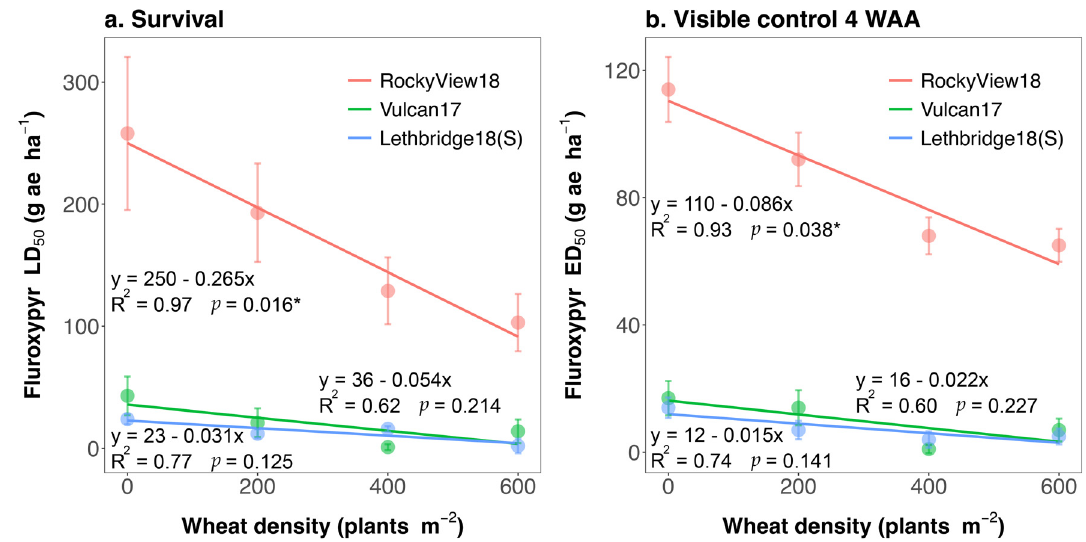
Figure 3. The lethal rate of fluroxypyr required to decrease kochia plant survival by 50% (LD 50 ) ( a ), and the effective rate of fluroxypyr required to achieve 50% visible control (ED 50 ) four weeks after application (WAA) ( b ), for the three kochia populations [RockyView18, Vulcan17, and Lethbridge18(S)] and four wheat plant densities (0, 200, 400, and 600 plants m − 2 ). Dots indicate the predicted LD 50 or ED 50 values, while error bars indicate ± SE. * indicates a significant difference in slope of the line from 0 at p < 0.05.